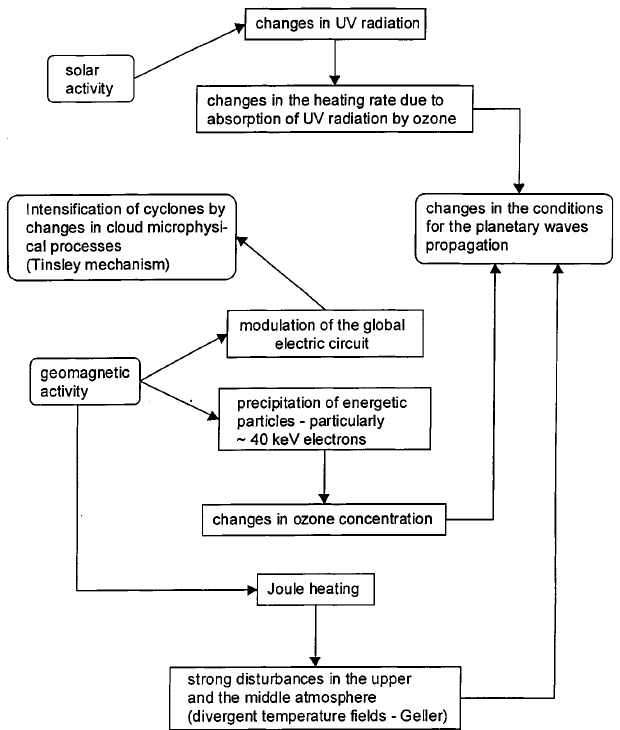
Fig. 7. A possible combination of simultaneous action of more mechanisms on processes in the troposphere